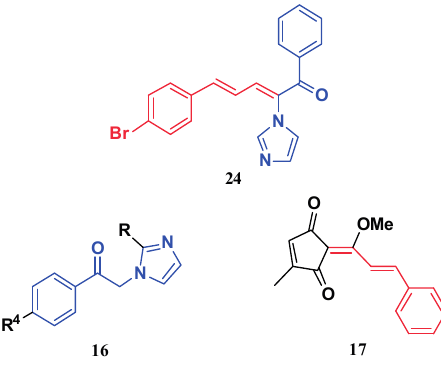
Figure 2. The structural scaffold of the lead compound synthesized in this study 24